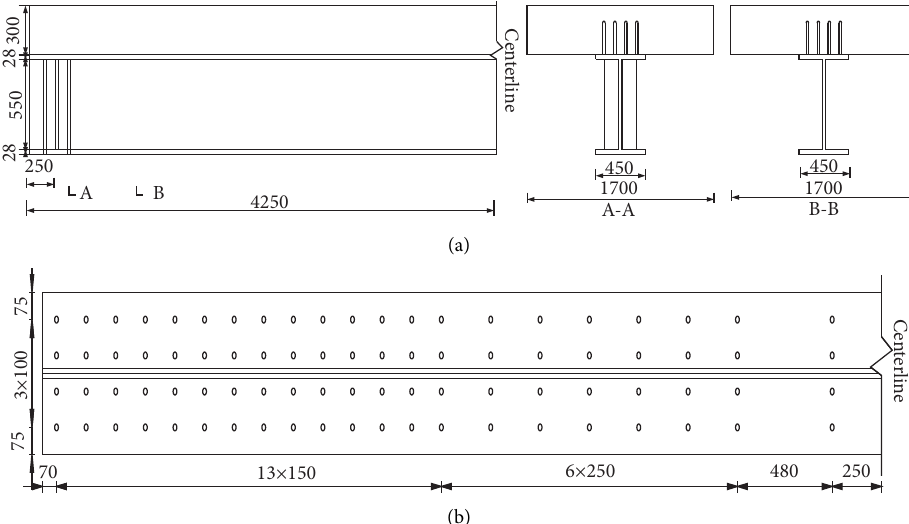
Figure 1: The section dimensions and shear stud arrangement of the SCCPB. (a) Section dimensions (mm). (b) Shear stud arrangement (mm).